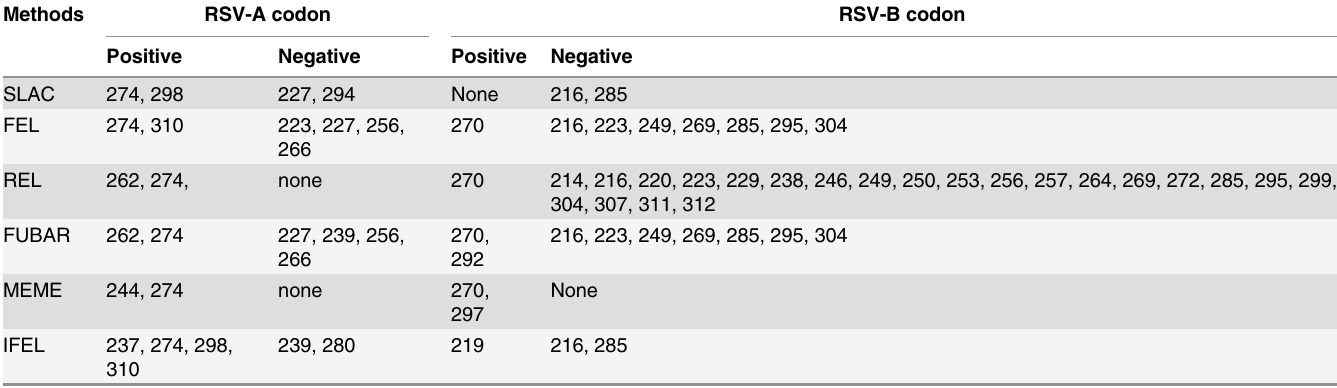
FEL: fi xed-effects likelihood; FUBAR: fast unconstrained Bayesian approximation; IFEL: random effects likelihood; MEME: mixed effects model of evolution; REL: internal branch fi xed-effects likelihood; SLAC: single-likelihood